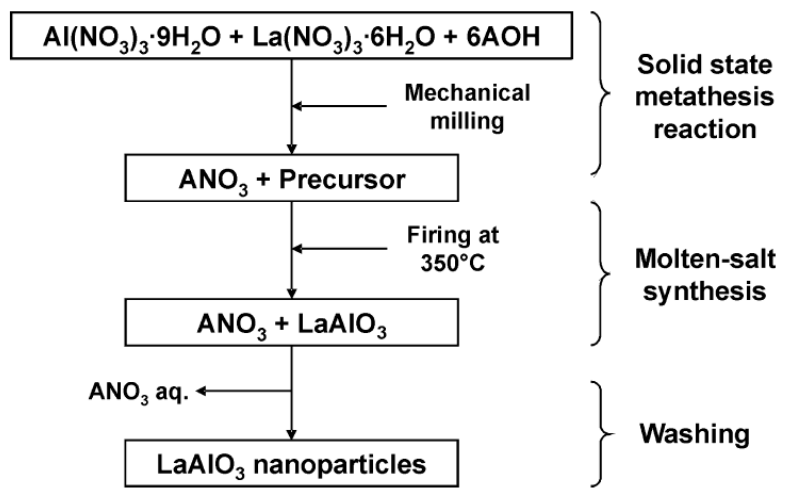
Figure 10. Flowchart of the experimental procedure for the synthesis of LaAlO 3 (Reprinted with permission from [51]).